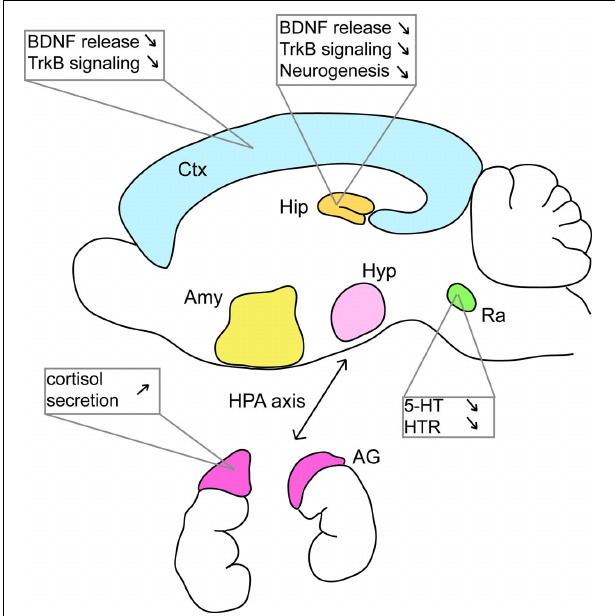
FIGURE 2 | Many defects at various locations in the brain of HD murine models can be linked to mood disorders. Studies in mouse models of HD have shown that BDNF/TrkB signaling is altered in various brain regions. Alterations of the serotonergic system and of the HPA axis have also been documented. AG, adrenal gland; Amy, amygdala; Ctx, cortex; Hip, hippocampus; Hyp, hypothalamus; Ra, raphe nuclei. See references in the